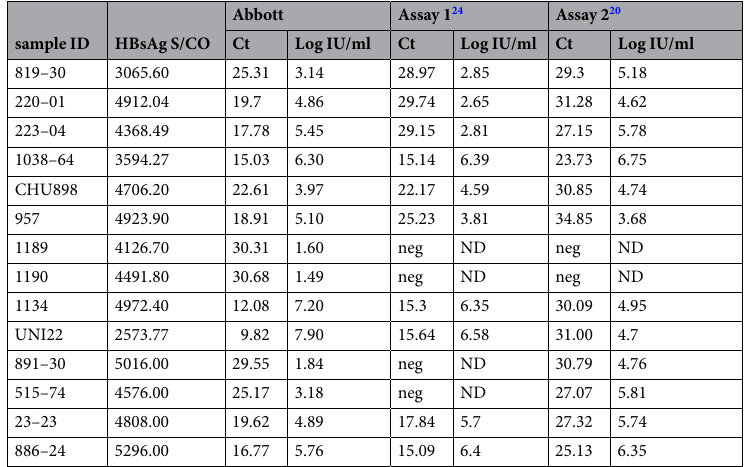
Table 4. Confirmation of HDV RNA positive samples using comparator assays. ND = not detected. Samples were extracted using a common protocol as described in the methods; amplification conditions specific to each assay were maintained for comparison (Supplemental Table S2). Shown are viral loads determined by standard curve analysis using the WHO HDV NAT standard.